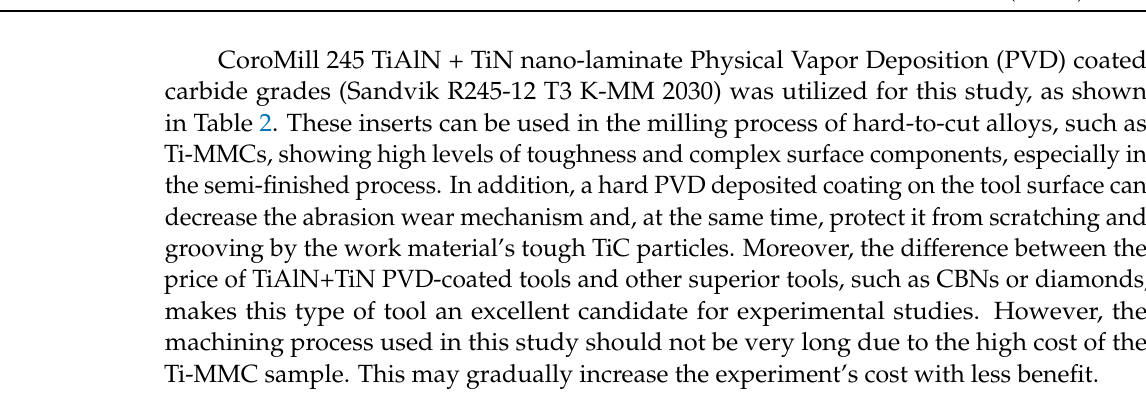
Table 2. CoroMill 245-12T3 carbide tool.